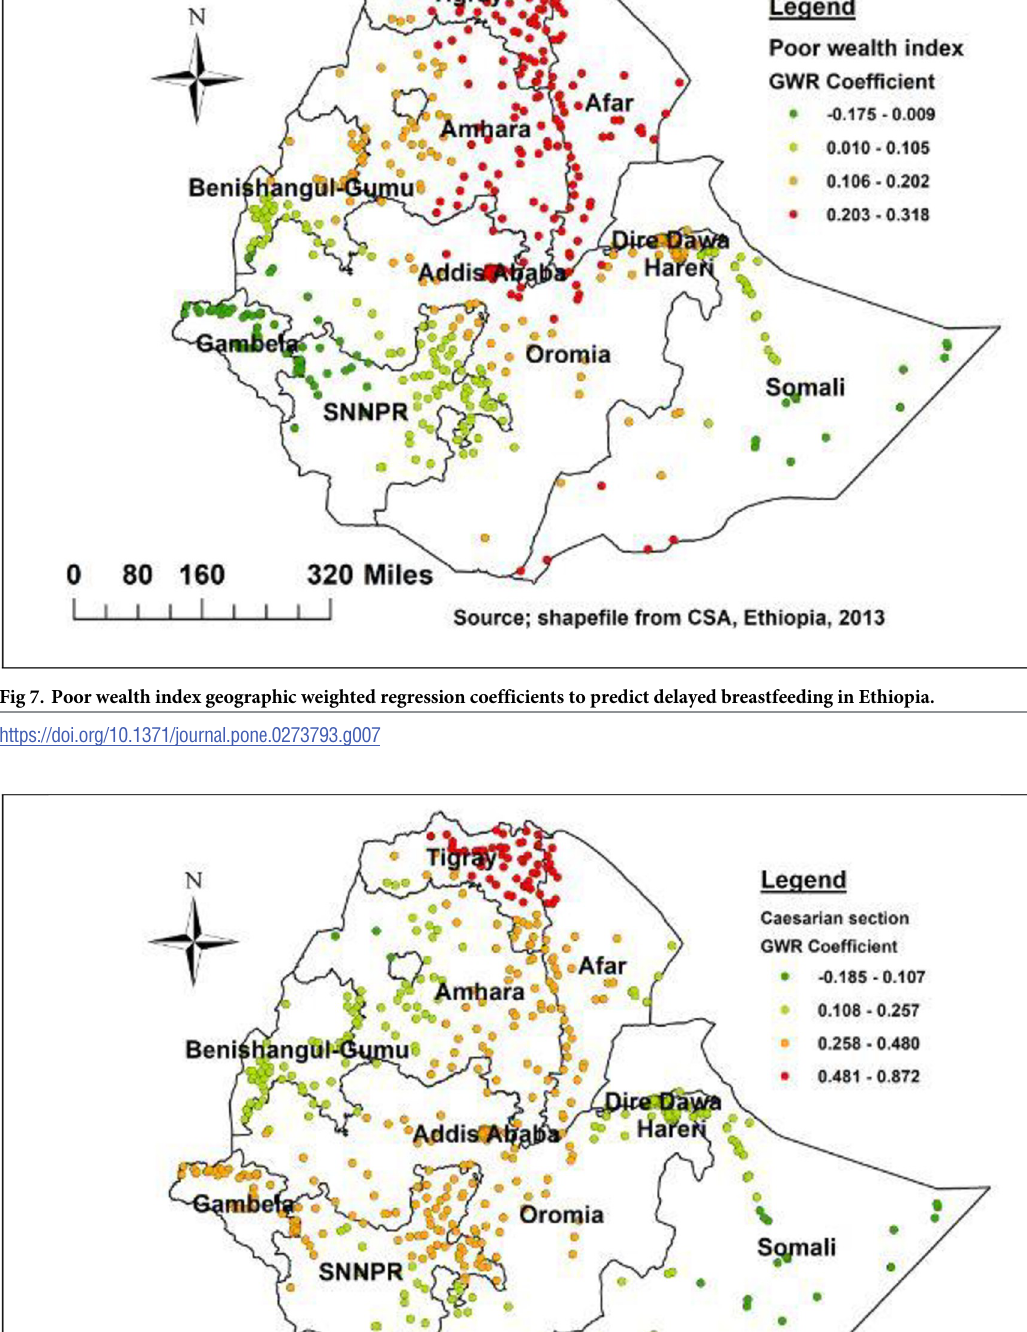
PLOS ONE | https://doi.org/10.1371/journal.pone.0273793 September 15,